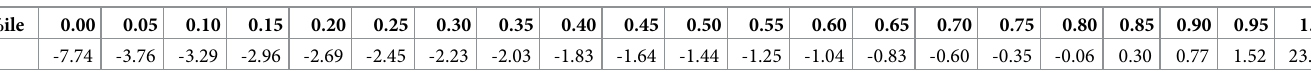
Table 2. Threshold